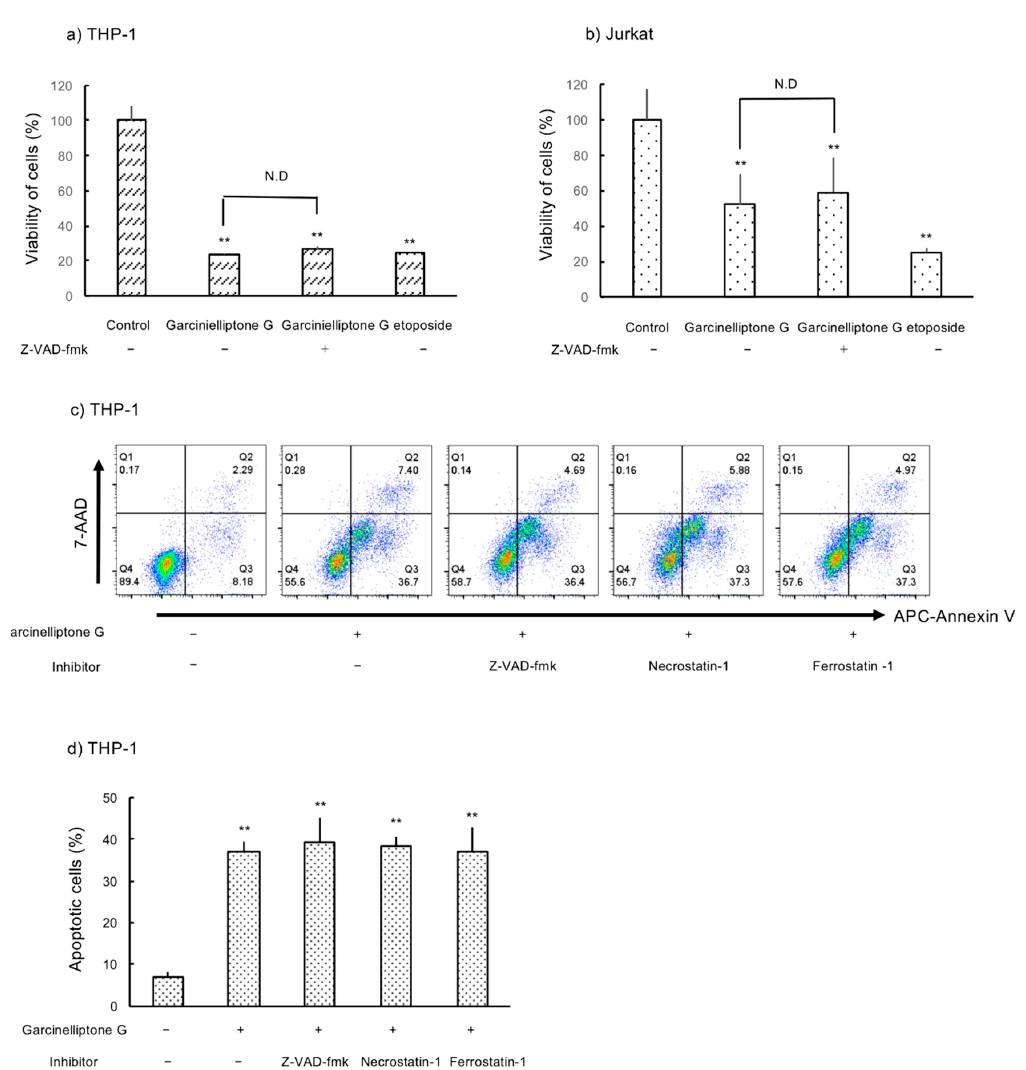
Figure 4. Pan-caspase inhibitor Z-VAD-FMK does not prevent garcinielliptone G ( 5 )-induced apoptosis. ( a ) THP-1 and ( b ) Jurkat cells were treated with Z-VAD-FMK (50 µ M) 1 h before garcinielliptone G ( 5 ) addition, and cell viability was determined by the WST-1 assay. ( c ) and ( d ) THP-1 cells were treated with inhibitors Z-VAD-FMK (50 µ M), necrostatin-1 (10 µ M), and ferrostatin-1 (1 µ M) 1 h prior to the addition of garcinielliptone G (5). These inhibitors did not prevent apoptosis caused by garcinielliptone G ( 5 ). Values are presented as the mean ± SD of three independent experiments. * p < 0.05, ** p <